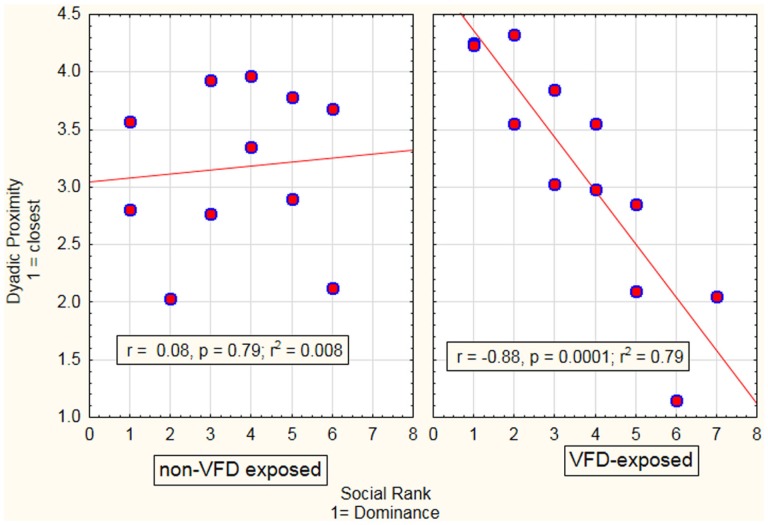
Relationship between maternal–infant proximity as a function of maternal social rank in VFD-exposed versus non-exposed dyads. A general linear model was performed with VFD exposure as the categorical variable, maternal social rank as the predictor variable and maternal–infant dyadic distance as the dependent variable. A significant interactive term of VFD exposure × maternal social rank [F(1; 19) = 11.97; p = 0.003] indicated that predictive effects of social rank on dyadic proximity were specific to VFD mothers with low-social rank predicting decreased dyadic distance (see figure for respective Pearson’s correlations).